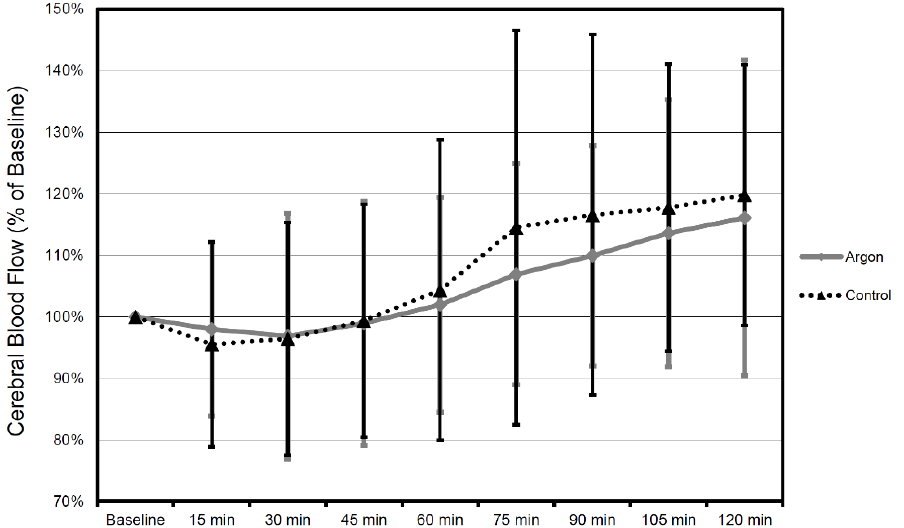
Figure 7. CBF values in time course 2 h after trauma in 15 min intervals. All values in relation to baseline 30 min prior to trauma (mean ± SD). Therapy was administered until 2 h after trauma (the number of animals were as follows: Argon = 9, Control = 9).